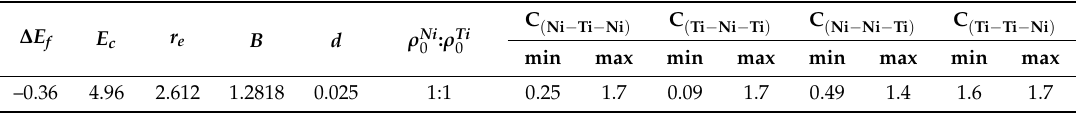
Table 1. Optimized second nearest-neighbor-modified embedded-atom method (2NN-MEAM) potential parameters for the NiTi system.